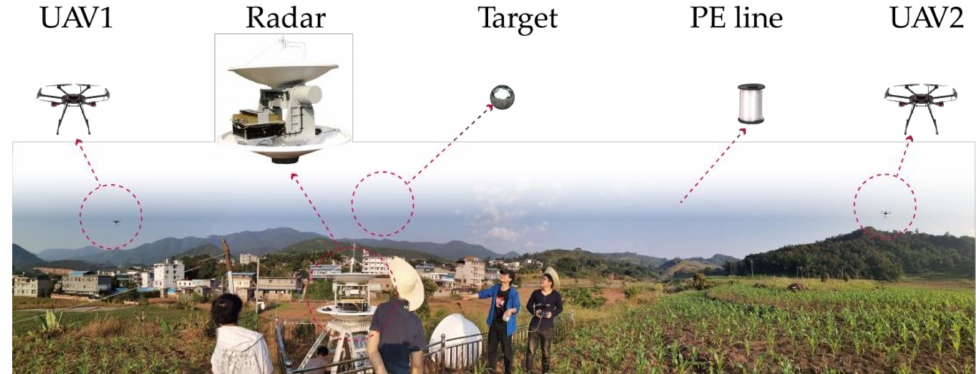
Figure 9. Field experiment for polarimetric calibration (the use of UAVs had been reported to the local air traffic control